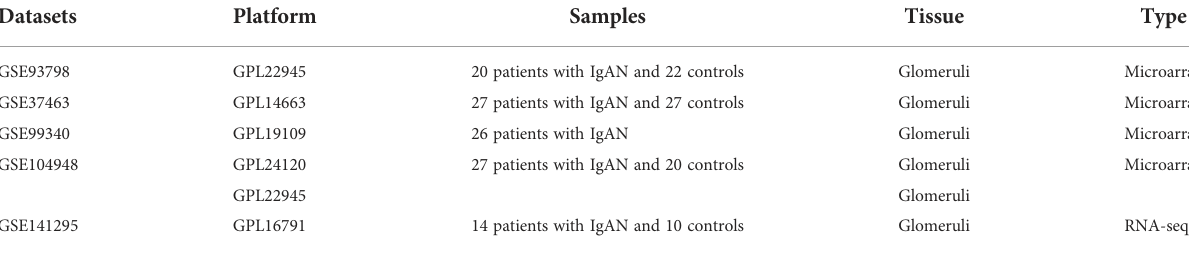
TABLE 1 The information of fi ve datasets obtained from GEO database. Datasets